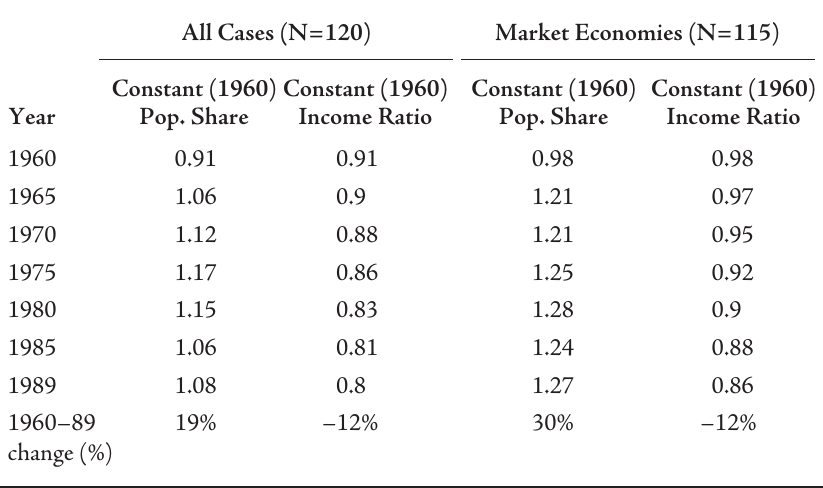
Table 5 – PWT World Income Inequality (VarLog) – Population versus Income Effects (Weighted